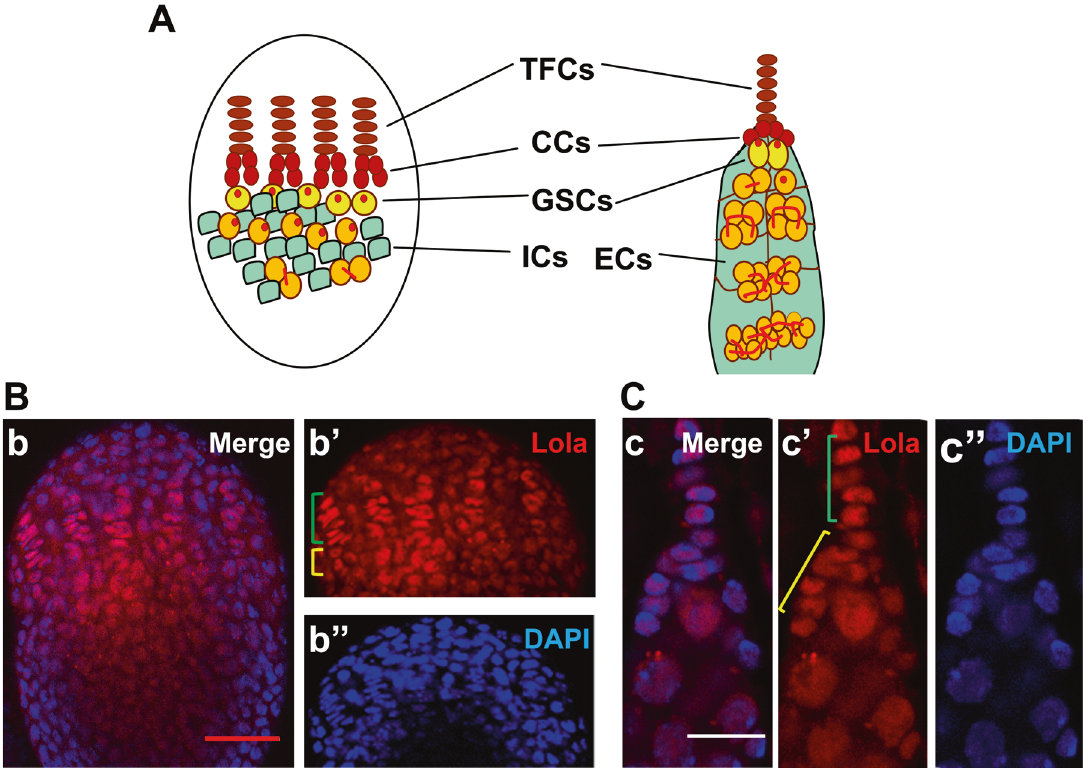
Fig. 1 Lola protein is expressed in terminal fi lament cells and cap cells of WPP and adult ovaries. A Schematic diagram of a Drosophila ovary in WPP (left) and adults (right) with cell types labeled. TFCs, Terminal Filament Cells; CCs, Cap Cells; GSCs, Germline Stem Cells; ICs, Intermingled Cells; ECs, Escort Cells. B, C Localization of Lola protein in the WPP ovary B and adult ovary C . Lola protein was detected by anti- Lola antibody ( b ’ and c ’ ) and nuclei were stained by DAPI ( b ” and c ” ). Lola protein accumulates in the nuclei of TFCs and CCs (green and yellow square brackets, respectively, in b ’ and c ’ ). Scale bars: 50 µm in B and 5 µm in C